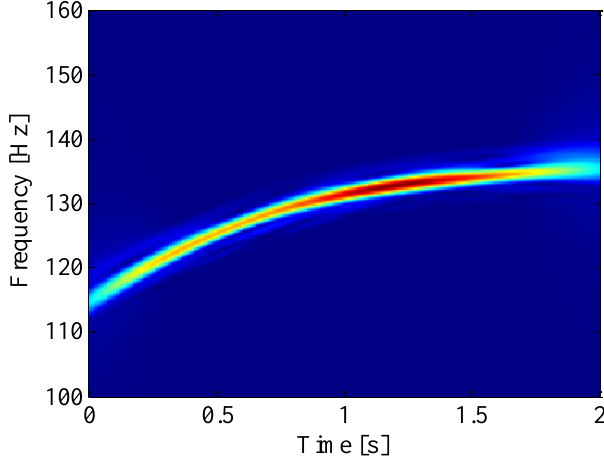
Figure 15. The ASTFT spectrogram of the extracted 19th harmonic.